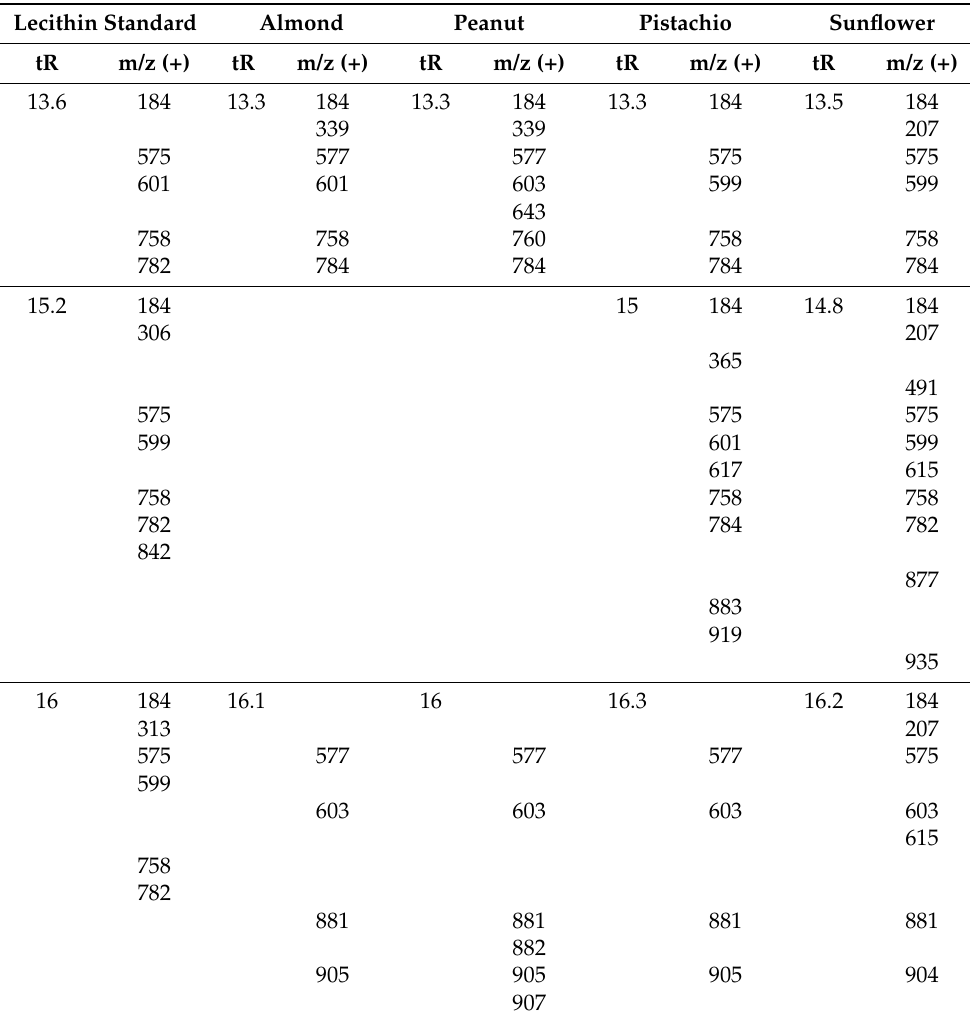
Table 2. Comparison of m/z values obtained in each retention time from a lecithin standard and from seed samples. Lecithin Standard Almond Peanut Pistachio